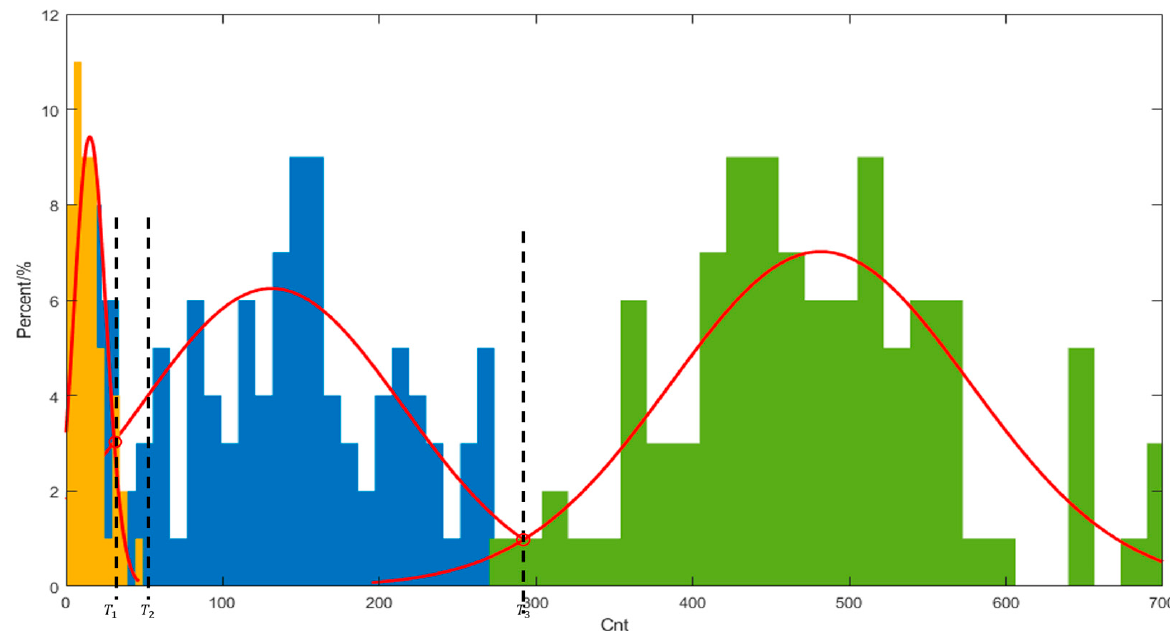
Figure 11. The histograms of the respective frequency distributions of cnt in the ABSENT, PRESENCE, and MOVING states and their fitted curves are shown in the figure. The solid line in Figure 10 represents the primary transfer path, whereas the dashed line represents the secondary transfer path. In real-world scenarios people move in and out of their seats, leading to the transition between present and absent states at each location, thus meaning that the transition between present and absent states must go through the movement state on the primary path. Additionally, the clustered result can be used as an event to trigger the target motion. During the state transfer, the state of the previous moment and the distribution of point clouds at the current moment jointly determine the state of the current